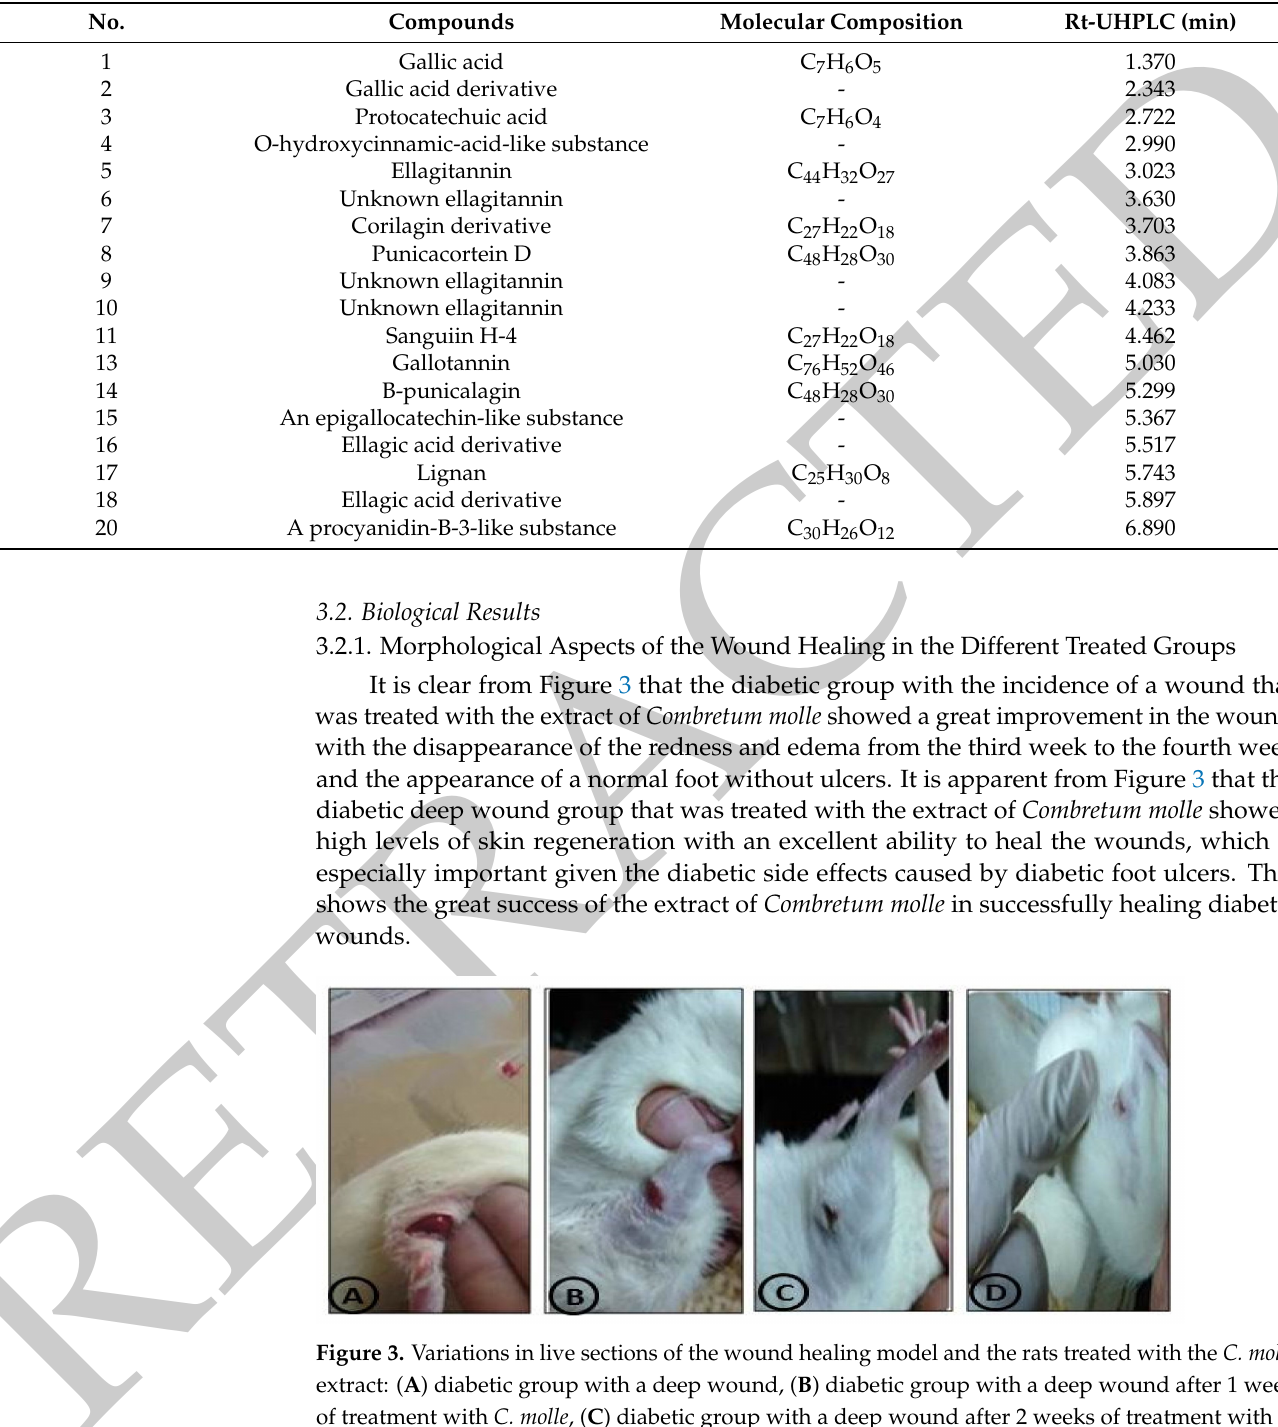
Table 2. Polyphenolic profile of the methanolic extract of Combretum molle for dried leaves of the plant. Data were recorded using UHPLC flight mass spectrometry.